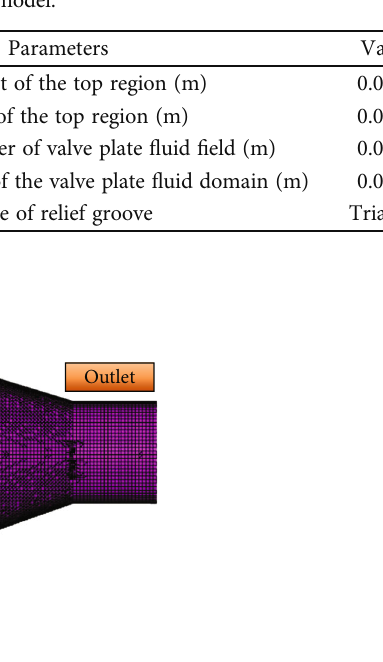
Figure 6: Fluid domain model and mesh model of axial piston pump model. Table 1: Geometric parameters of fl uid domain model.